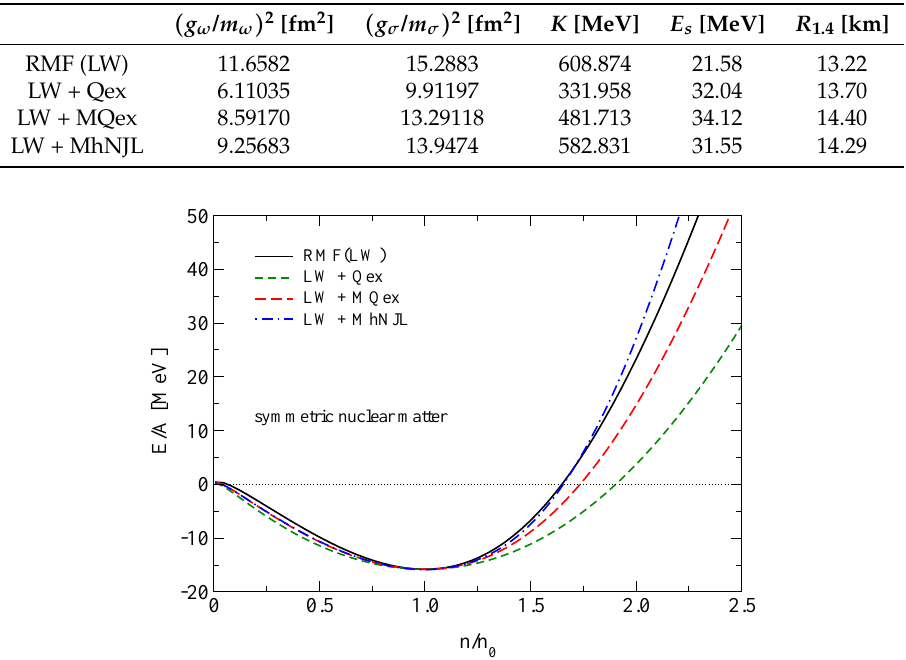
Table 2. Parameter sets for vector ( G ω = ( g ω / m ω ) 2 ) and scalar ( G σ = ( g σ / m σ ) 2 ) meson couplings,